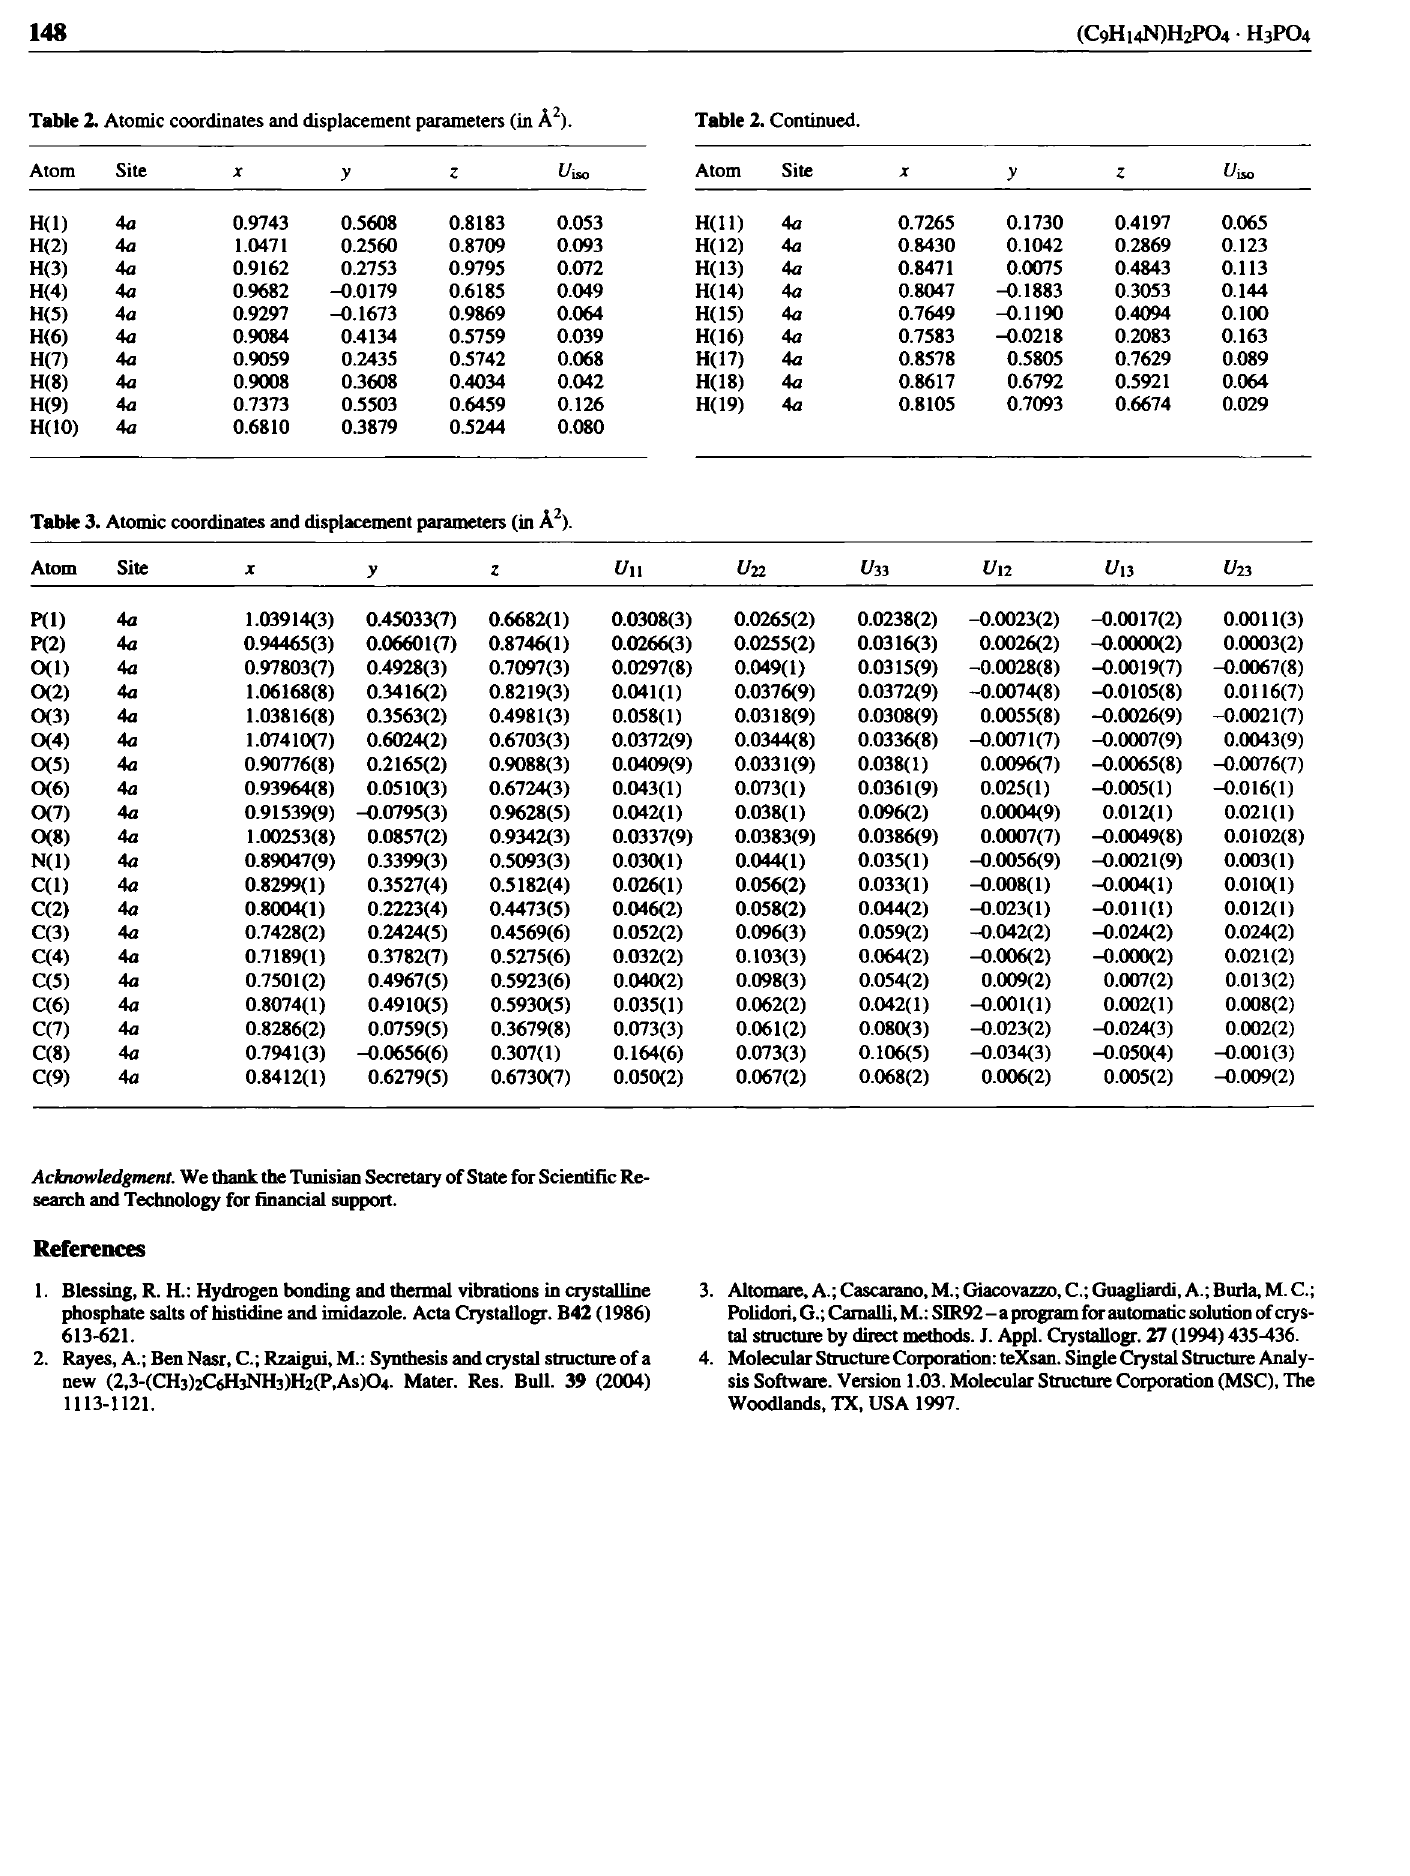
Table 2. Atomic coordinates and displacement parameters (in A 2 ).